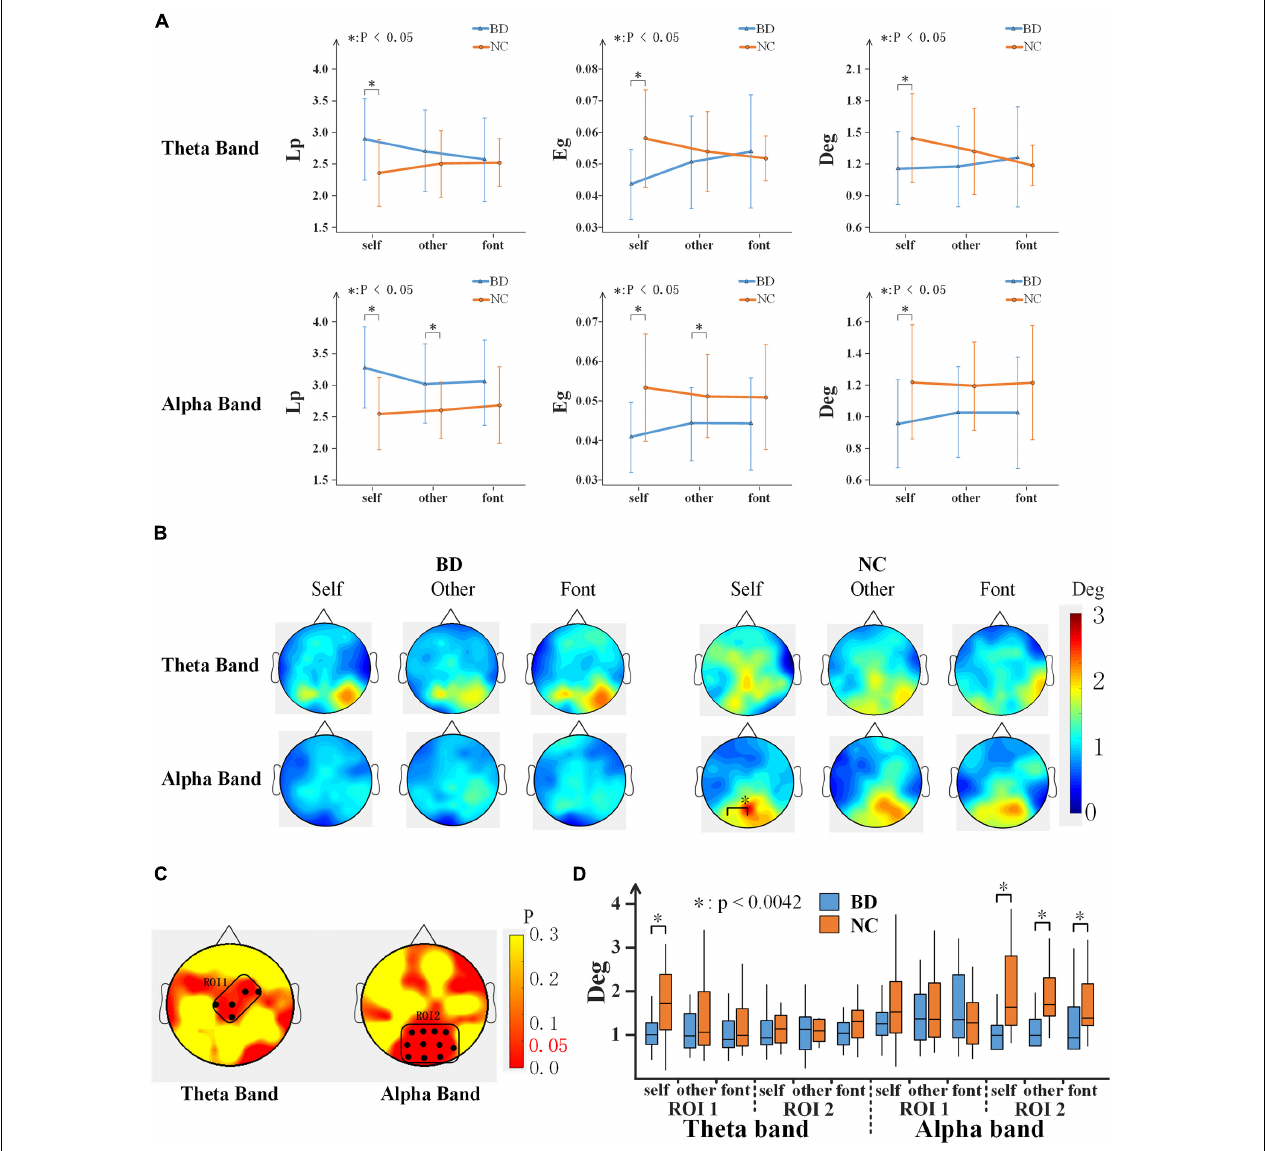
FIGURE 6 | (A) Network topology parameter values of the three conditions for BD and NC in the theta and alpha bands at 220–300 ms. Error bars indicate the standard deviations. (B) The topography shows the distribution of the degree values for BD and NC in regard to the three conditions in terms of the theta and alpha band activity at 220–300 ms. (C) ROI (black dots) defined as the topography of ANOVA result. (D) The average Deg of two ROIs for BD and NC for all conditions. BD, bipolar disorder; NC, normal control; Lp, path length; Eg, global efficiency; Deg, degree; ROI, region of interest; ANOVA, analysis of